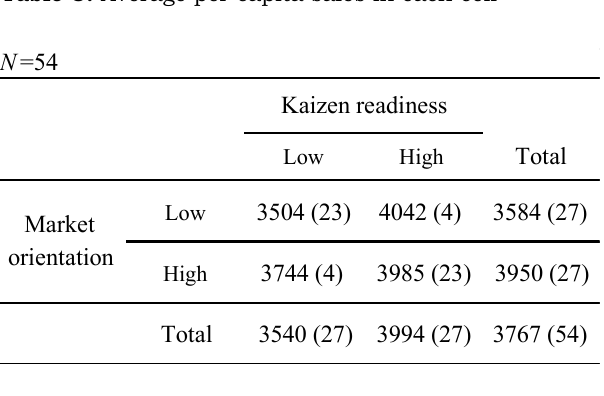
Table 3. Average per capita sales in each